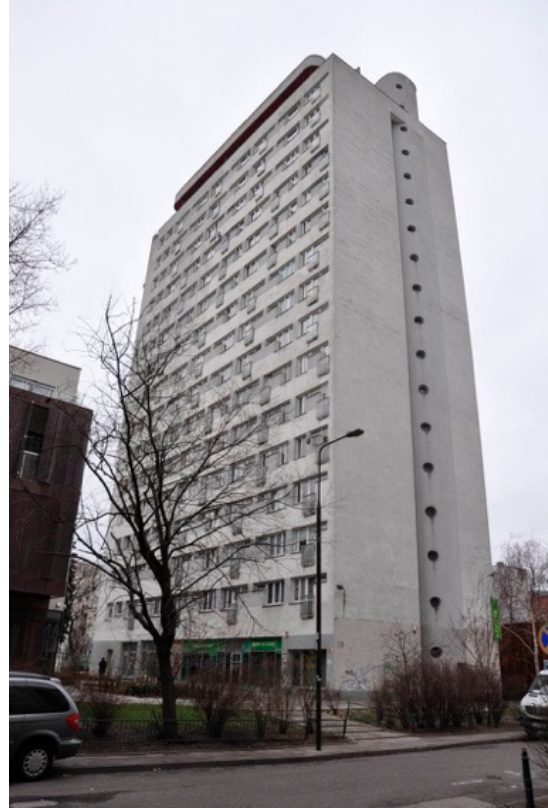
Figure 4. Building at 1B Ludna Street.